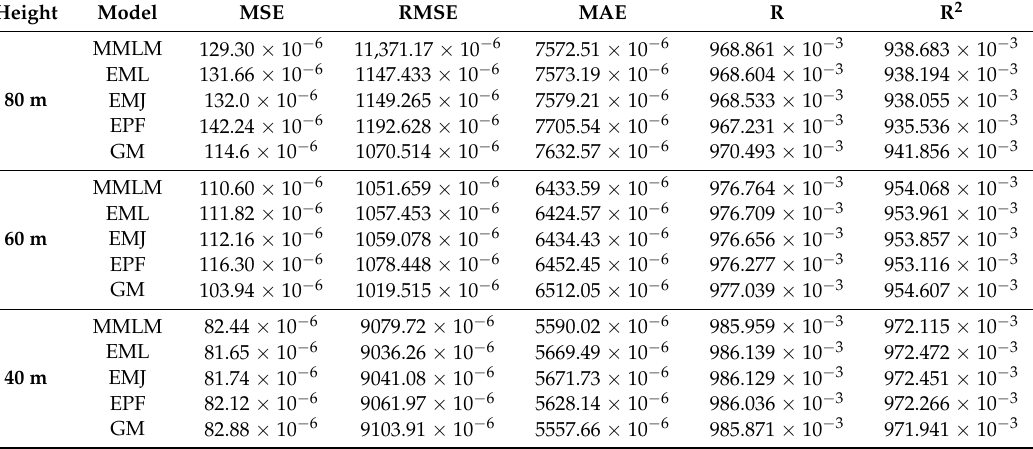
Table 7. Results of performance evaluation of different Weibull